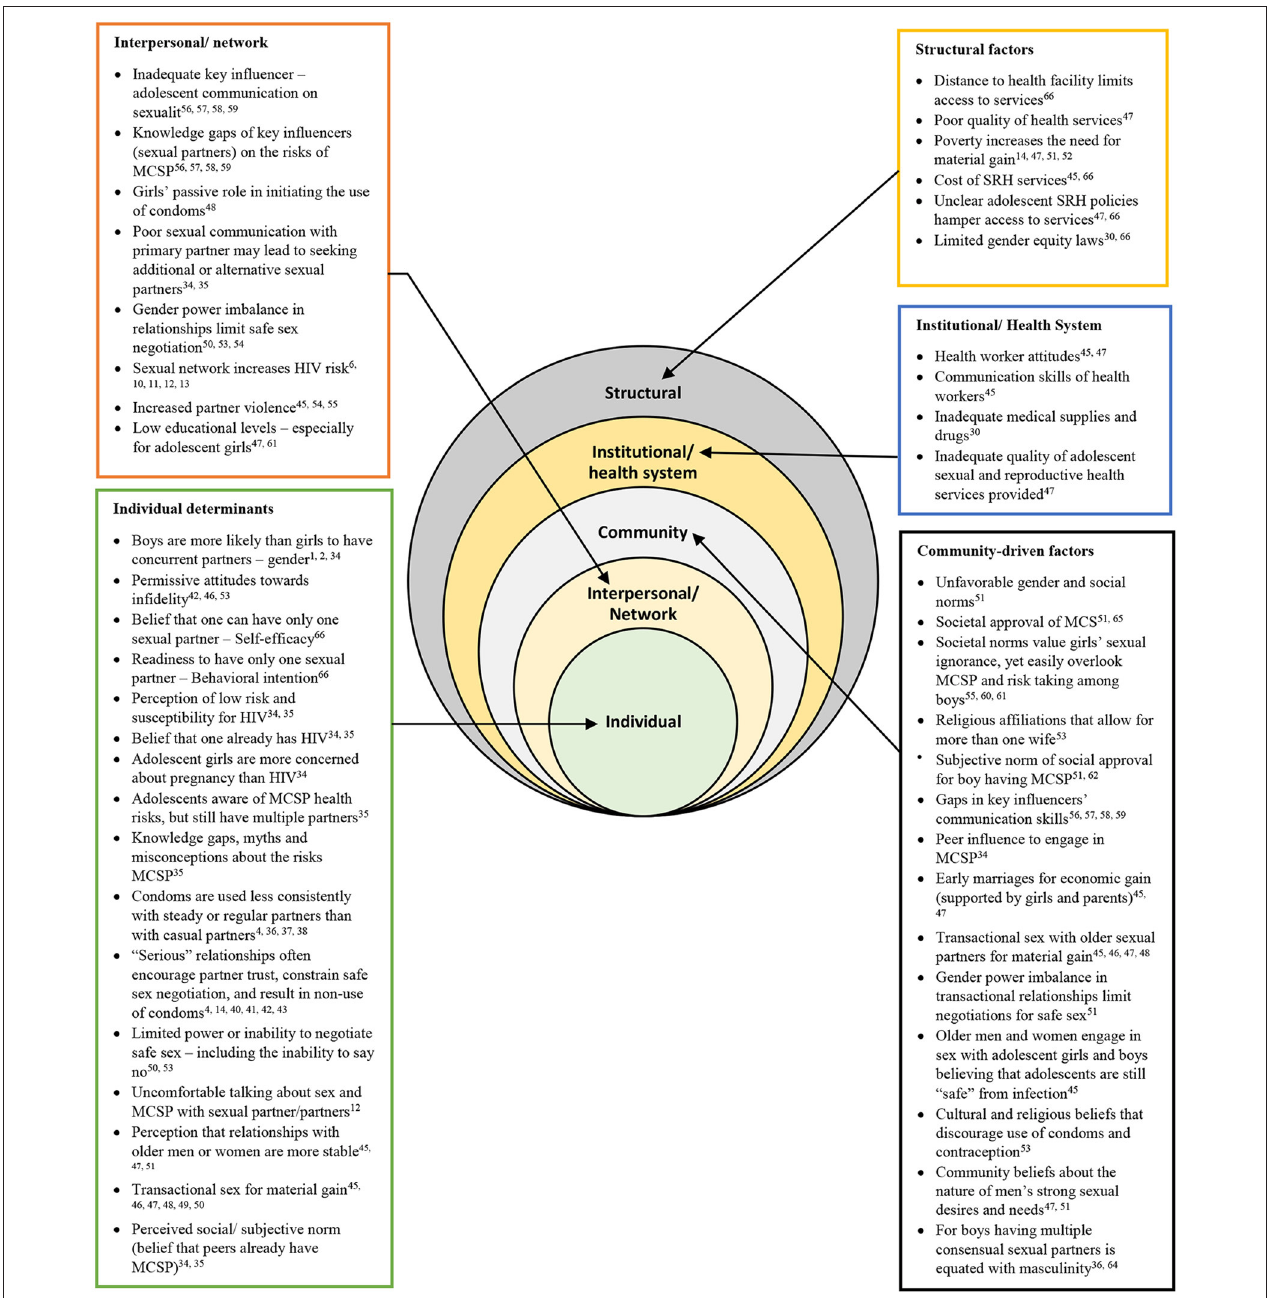
FIGURE 1 | Determinants of multiple sexual partnerships among adolescents at all levels of the Social Ecological Model based on literature findings. Depiction of Social-Ecological Model adapted from Mckee et al. (32) and Kaufman et al. (30). MCSP, Multiple Concurrent Sexual Partnerships; SRH, sexual and reproductive health.